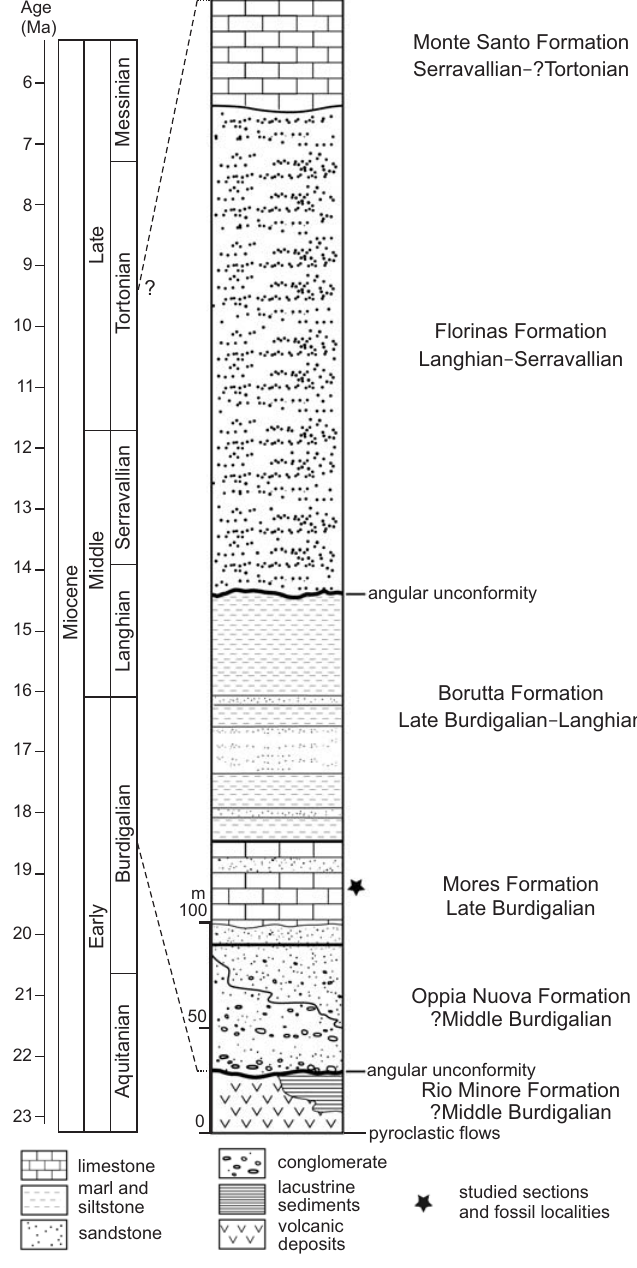
Fig. 2. Stratigraphy of the Miocene volcano-sedimentary succession of the Porto Torres Basin (based on Mazzei and Oggiano 1990; Martini et al. 1992; Francolini 1994; Funedda et al. 2000, 2003; Bossio et al.